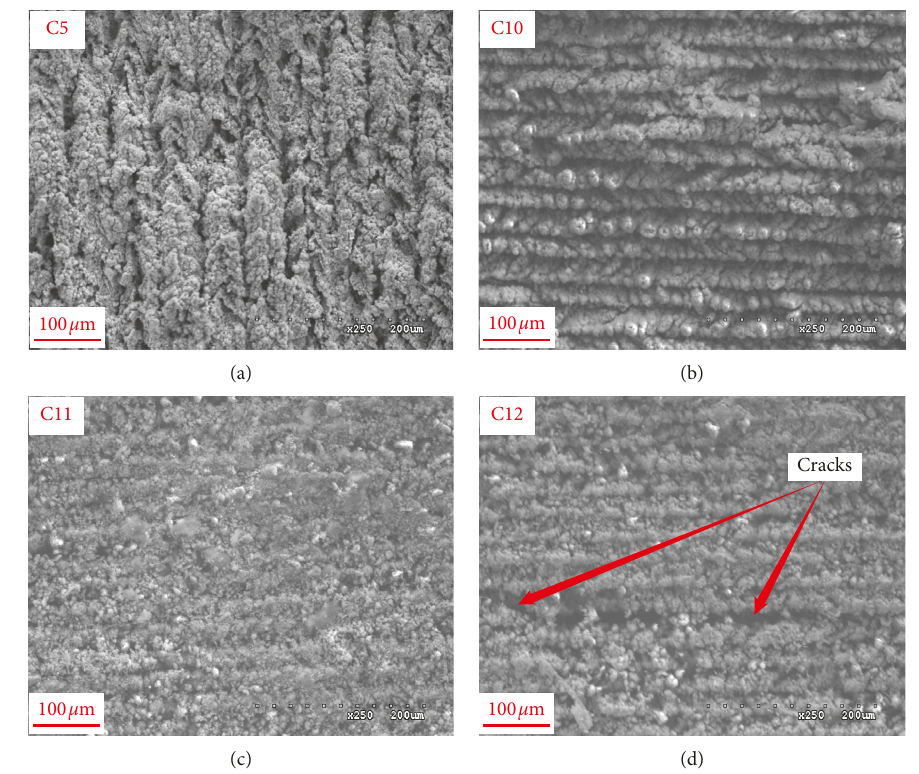
Figure 5: Morphology of surfaces laser-processed 1, 2, 4, and 6 times.